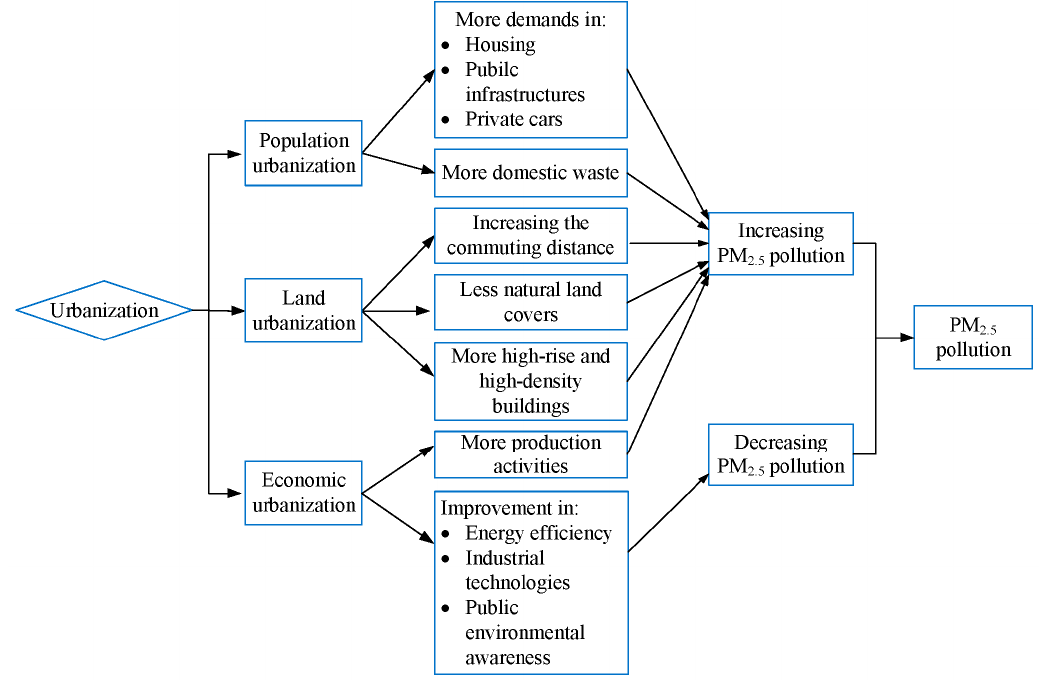
Figure 5. The impact mechanisms of urbanization on PM 2.5 pollution.